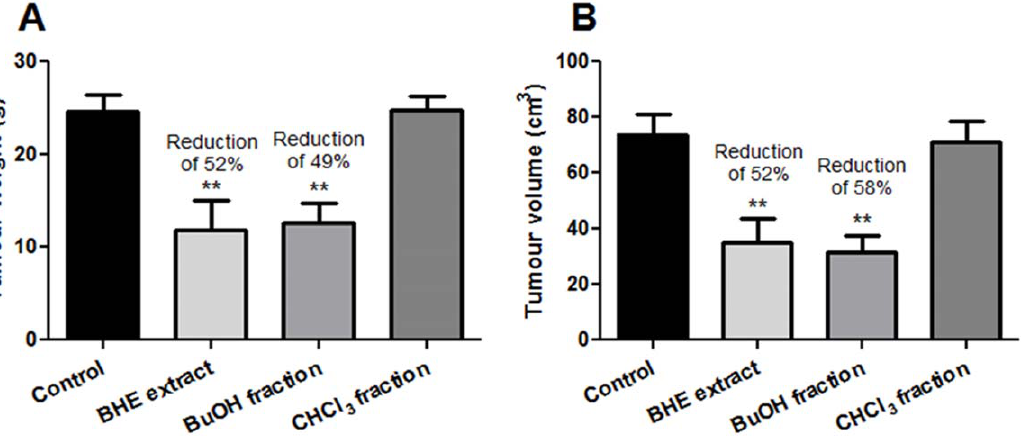
Figure 4. Tumour mass (A) and volume (B) in Walker-256 tumour-bearing rats treated with BHE Uncariatomentosa extract or its two fractions (BuOH and CHCl 3 ). Symbols: ** p , 0.01 as compared to the control